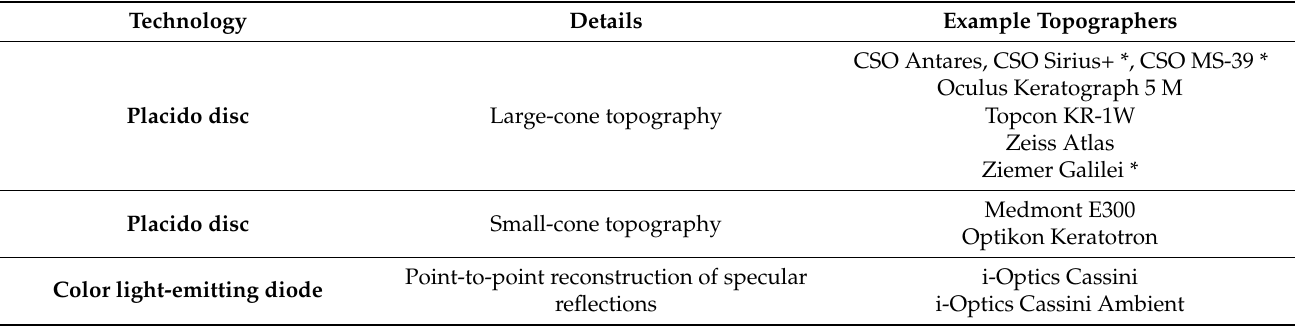
Figure 1. Corneal topography in the Oculus Keratograph 5 M. Table 1. Techniques employed for corneal topography in some of the currently used devices.